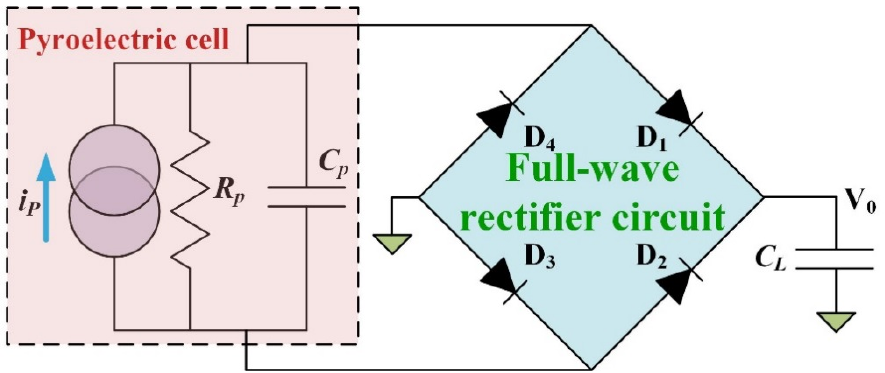
Figure 4. Full-wave rectifier circuit used to store the induced charge from the pyroelectric cell and the disk